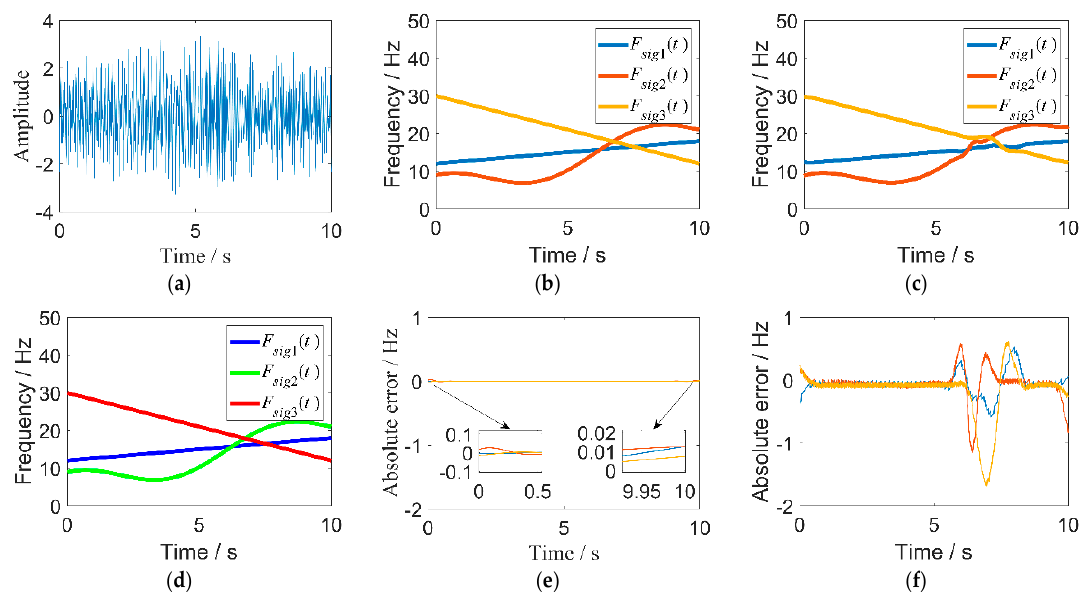
Figure 2. Frequency analysis of estimated component signal. ( a ) Original artificial signal. ( b ) Frequency of original component signal in time domain. ( c ) Frequency of estimated component signal extracted by RPRG. ( d ) Frequency of estimated component signal extracted by VSME. ( e ) Absolute error of estimated component signal frequency extracted by VSME. ( f ) Absolute error of estimated component signal frequency extracted by RPRG.